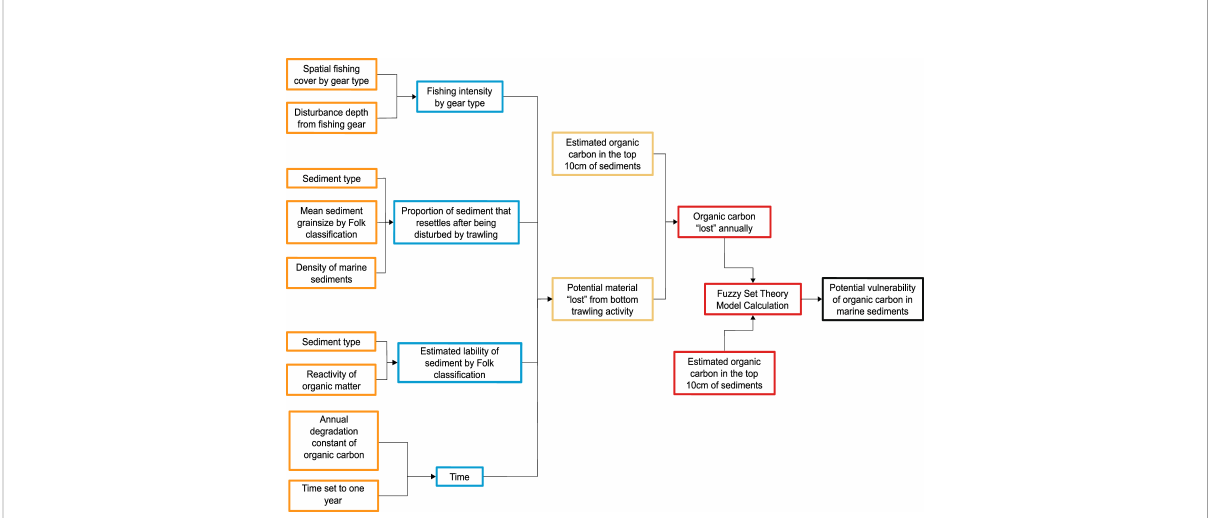
FIGURE 5 Simpli fi ed schematic of the work fl ow steps taken to generate the organic carbon vulnerability estimates. Coloured boxes represent different stages within the calculation. Preparation of the data used in this study was conducted within RStudio (Ver. 2021.09.1 + 372) and ArcGIS (Ver. 10.7). Rasters were rescaled where necessary to be on the same scale to ensure a single-pixel calculation overlay. Calculations and spatial analysis were conducted within ArcGIS using the raster calculator tool, fuzzy membership tool, and fuzzy overlay